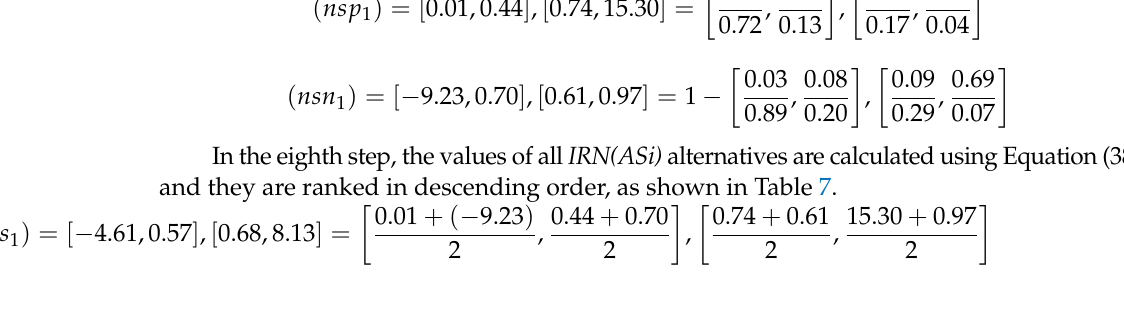
Table 7. Final results and ranking obtained using the IRN EDAS